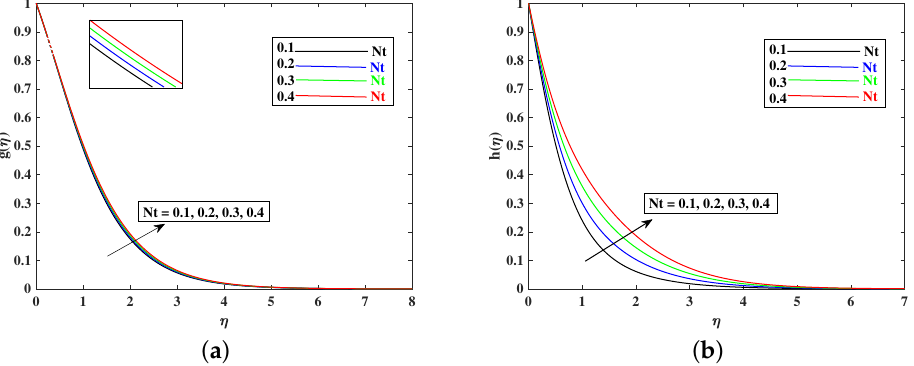
Figure 11. Variation of Nt to influence the temperature and concentration Profile. ( a ) Variation of Nt to influence the temperature. ( b ) Variation of Nt to influence the concentration profile.